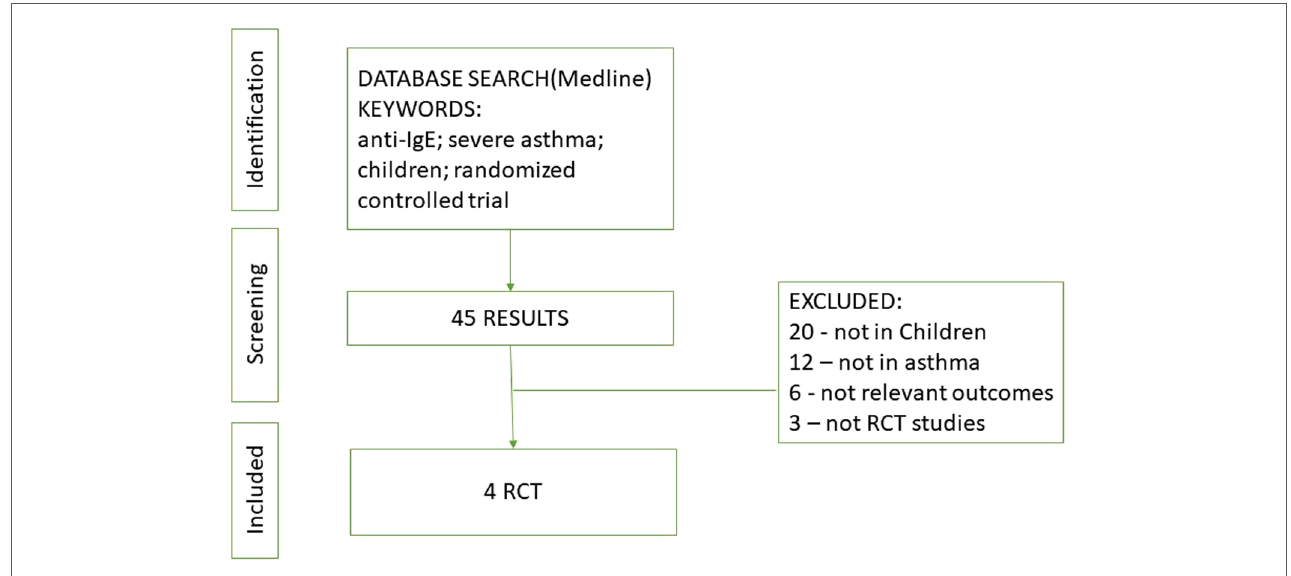
FIGURE 1 Process identifying studies eligible for the systematic